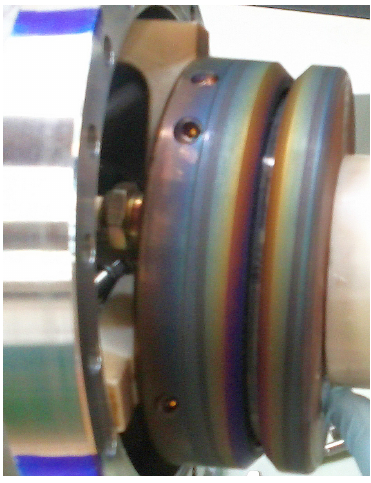
Figure 2. Image of the radial ion source during a loading